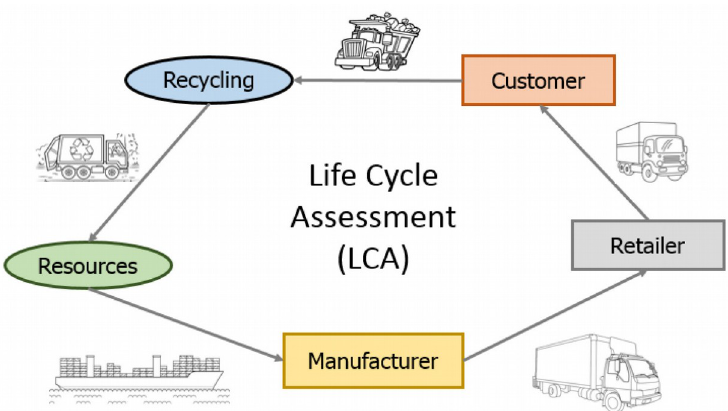
Figure 1. Life Cycle Assessment